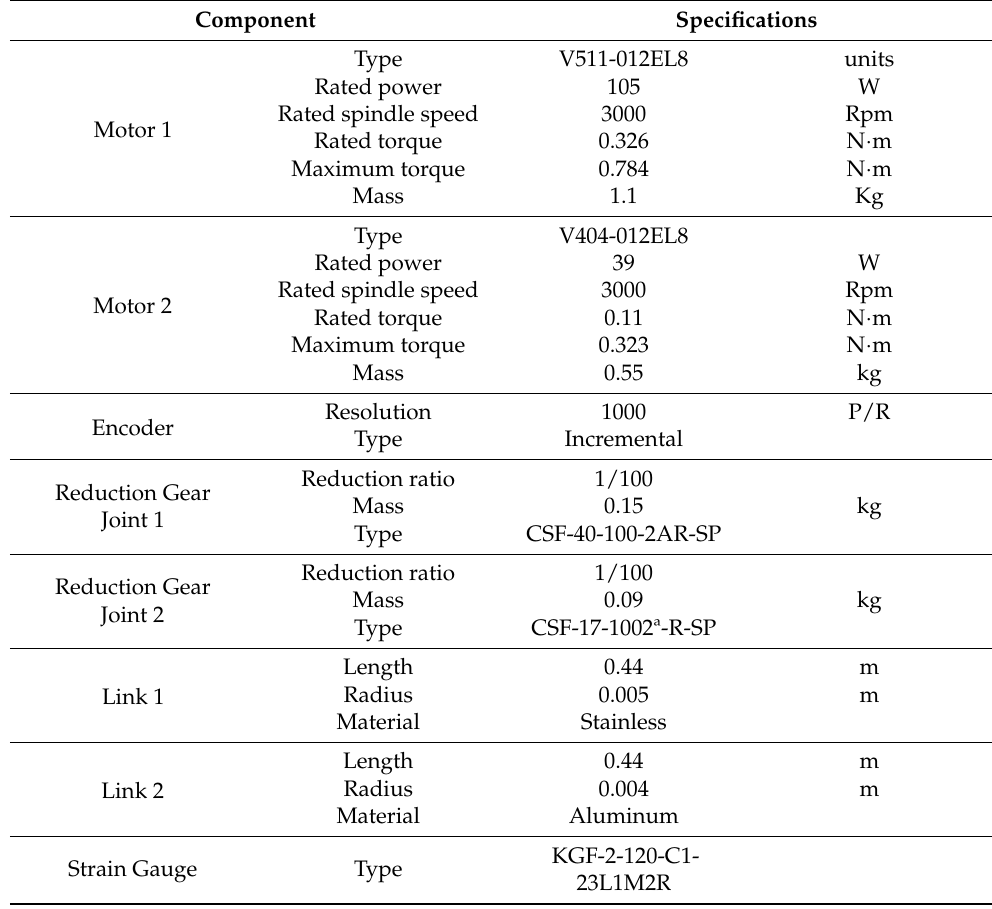
Table 1. Parameter specifications for the flexible